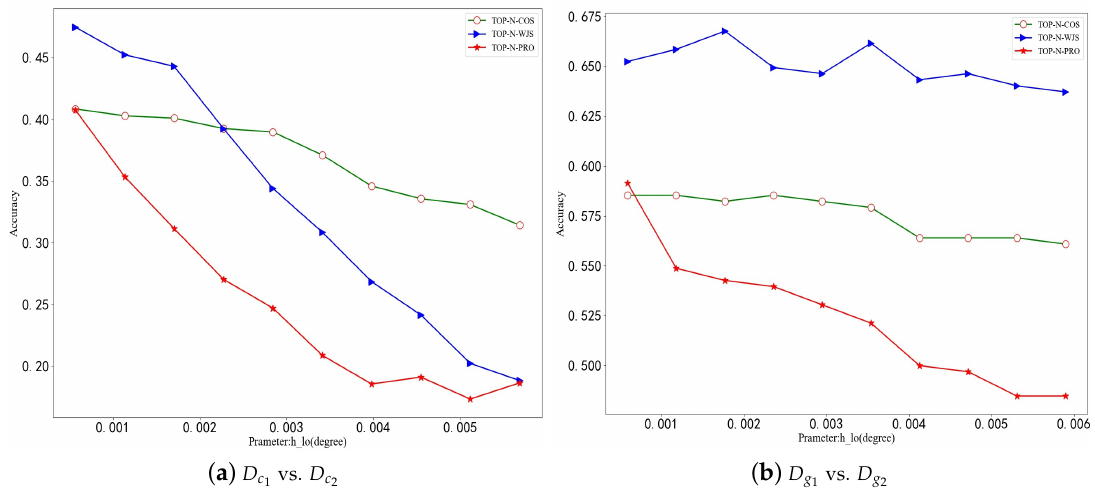
Figure 1. Comparing TOP-N-COS, TOP-N-PRO and TOP-N-WJS by accuracy vs. h _ lo . ( a ) Cabspotting, ( b )